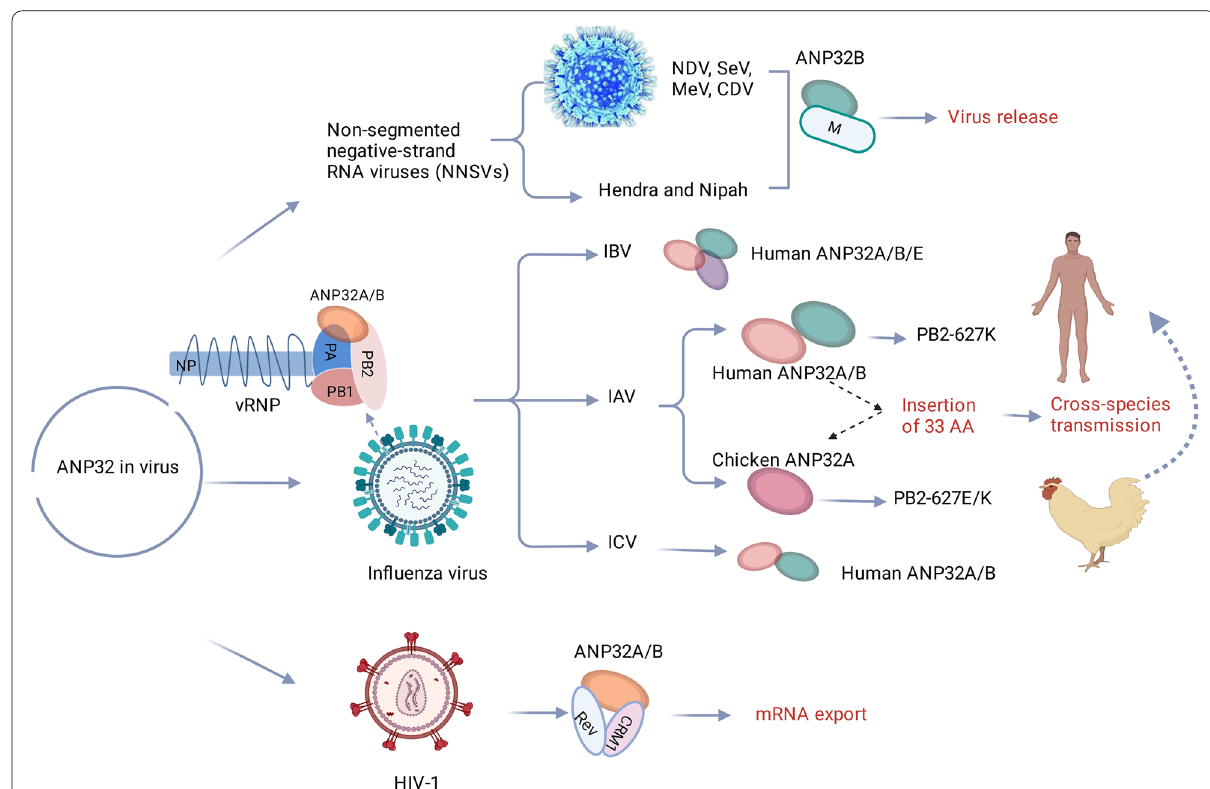
Fig. 3 The roles of ANP32 family proteins in different viral life cycles. Newcastle disease virus (NDV), Sendai virus (SeV), measles (MeV) and canine distemper virus (CDV), Viral ribonucleoprotein complex (vRNP), Polymerase basic protein 1 (PB1), Polymerase basic protein 2 (PB2), and Polymerase acidic protein (PA), nucleoprotein (NP), Influenza A virus (IAV), Influenza B virus (IBV), Influenza C virus (ICV), Human immunodeficiency virus-1 (HIV-1), Regulator of expression of virion protein (Rev), Chromosome region maintenance 1